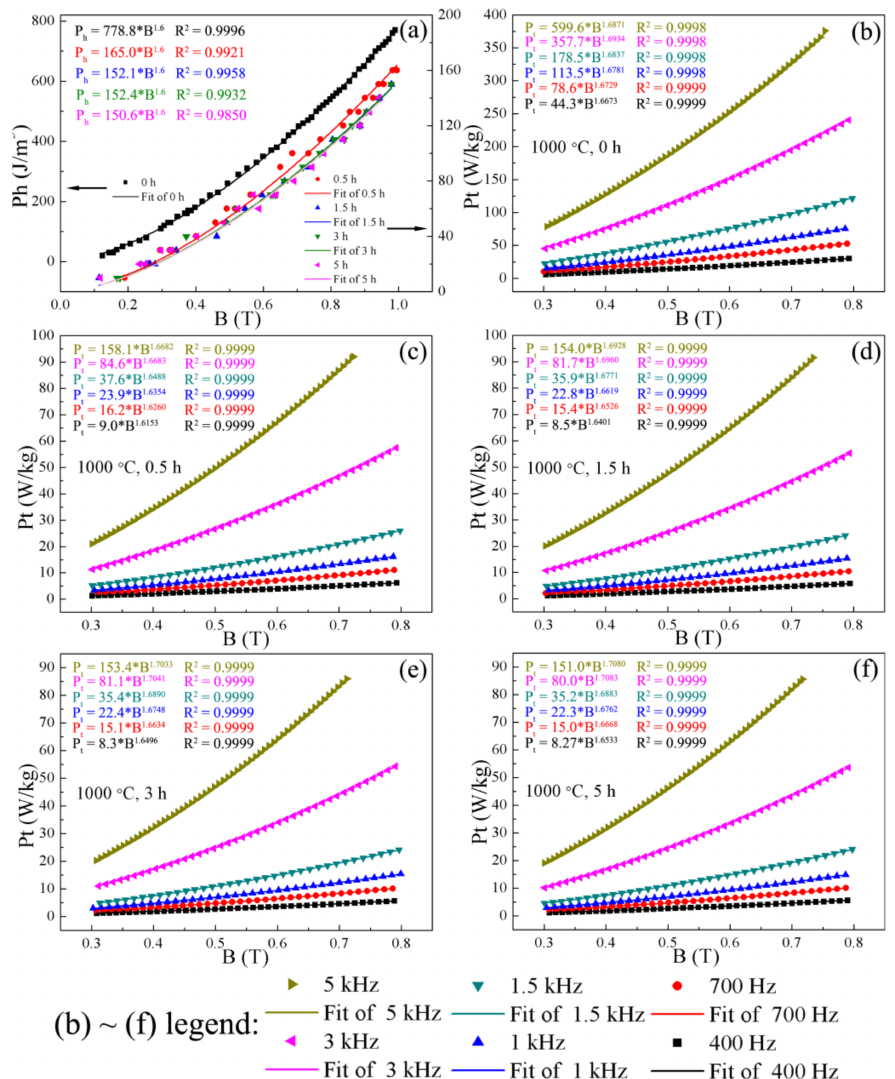
Figure 3. DC iron losses ( P h ) and AC iron losses ( P t ) and fit results before and after heat treatment, ( a ) DC iron losses–magnetic induction curves, which has two y axes: the left vertical axis represents DC iron losses ( P h ) before heat treatment and the right vertical axis represents DC iron losses ( P h ) after heat treatment with different duration; ( b – f ) AC iron losses–magnetic induction curves at different frequencies. R 2 is the goodness of fit wherein, the closer the value is to 1, the better the fit